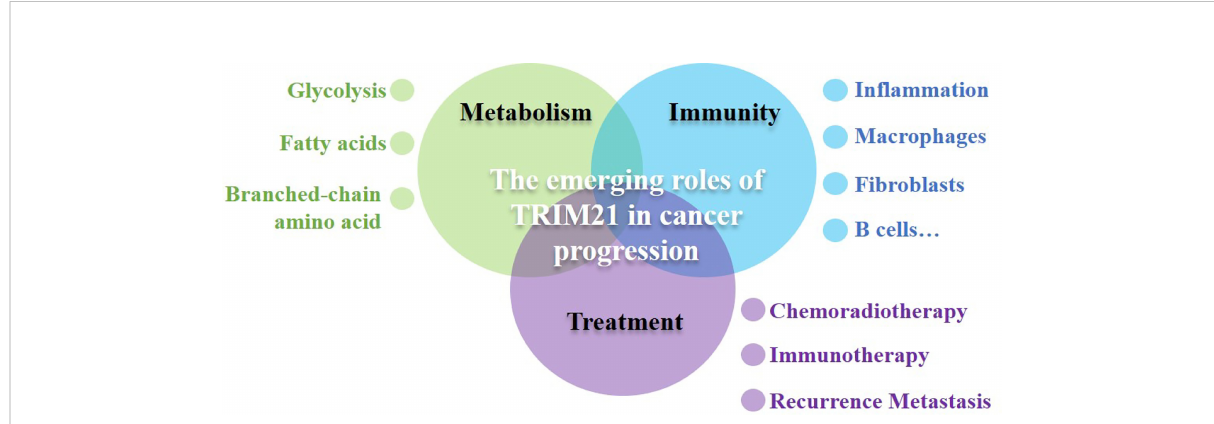
FIGURE 1 The emerging roles TRIM21 in coordinating cancer metabolism, immunity and cancer treatment. TRIM21 acts at multiple nodes to control cancer metabolic reprogramming inhibiting the increased metabolic demands of malignancy including glycolysis, fatty acids metabolism and branched-chain amino acid metabolism. TRIM21-mediated metabolic regulation not only indirectly effects immune cell in fi ltration, but also cross-talks innate immunity and adaptive immune directly, takes part in balancing immune response. TRIM21 also has indispensable roles in mediating cancer therapeutic effects, playing a decisive role in the fate of cancer.TRIM21 has tremendous application potential in cancer diagnosis, treatment and